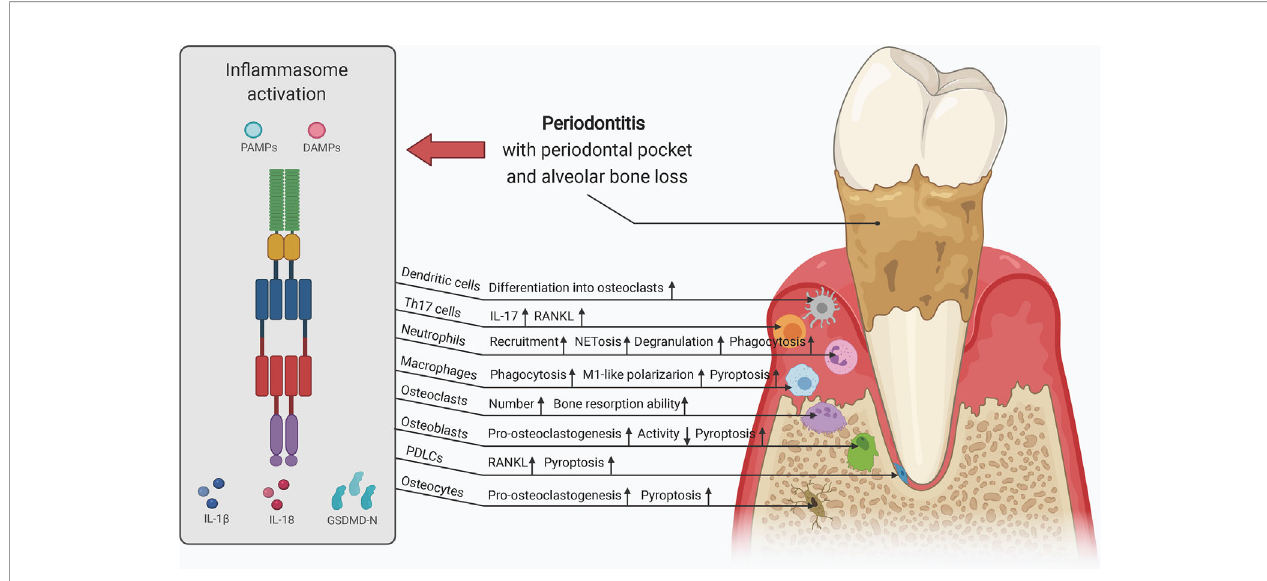
FIGURE 4 | Schematic of the role of in fl ammasome activation in alveolar bone loss (e.g., periodontitis). In fl ammasome activation is pivotal in alveolar bone loss via the following mechanisms: 1) increasing osteoclast activity; 2) decreasing osteoblast activity; 3) creating a pro-in fl ammatory milieu that facilitates bone resorption; and 4) causing periodontium in fl ammation by affecting periodontal ligament cells. Osteoclasts, osteoblasts, osteocytes, PDLCs, macrophages, neutrophils, T cells, and dendritic cells may be affected by inappropriately increased in fl ammasome activity, contributing to dysregulation of alveolar bone remodeling. DAMP, damage- associated molecular pattern; PAMP, pathogen-associated molecular pattern; PDLCs, periodontal ligament cells; RANKL, receptor activator of NF- k B ligand. Th17 cells, T helper 17